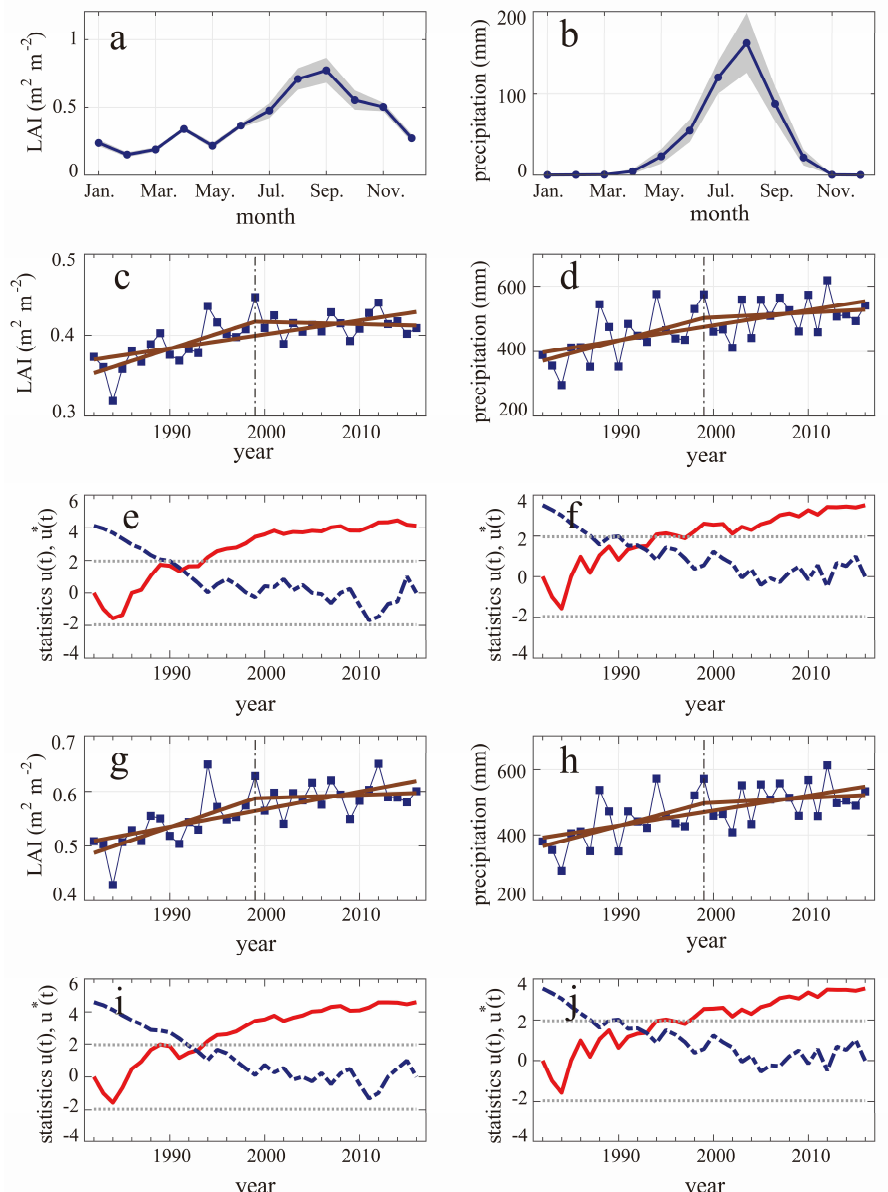
Figure 2. Time series of LAI and precipitation between 1982 and 2016. ( a–b ) Seasonal patterns of LAI and precipitation based on the annual averages between 1982 and 2016. Blue curves are the averages of each month with standard deviations indicated by grey areas. ( c–d ) Interannual time series (blue curves with squares) with corresponding linear fit between 1982 and 2016 and piecewise linear regression (PLR) analysis fits, using 1999 at the turning point. ( e–f ) Mann–Kendall–Sneyers MKS analysis of annual LAI and precipitation between 1982 and 2016 with forward ( u k , red line) and backward ( u* k , blue dashed line). ( g–j ) Similar to ( c–f ) but using June to November (J–N) LAI and May to October (M – O) precipitation instead.